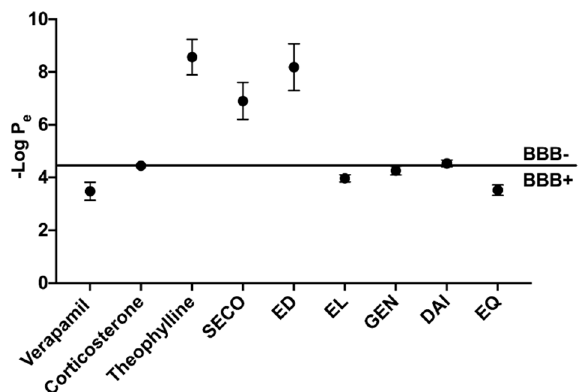
Figure 3. Assessment of blood–brain barrier passive permeability of polyphenols determined by PAMPA. Positive (verapamil), intermediate (corticosterone) and low (theophylline) permeability controls.